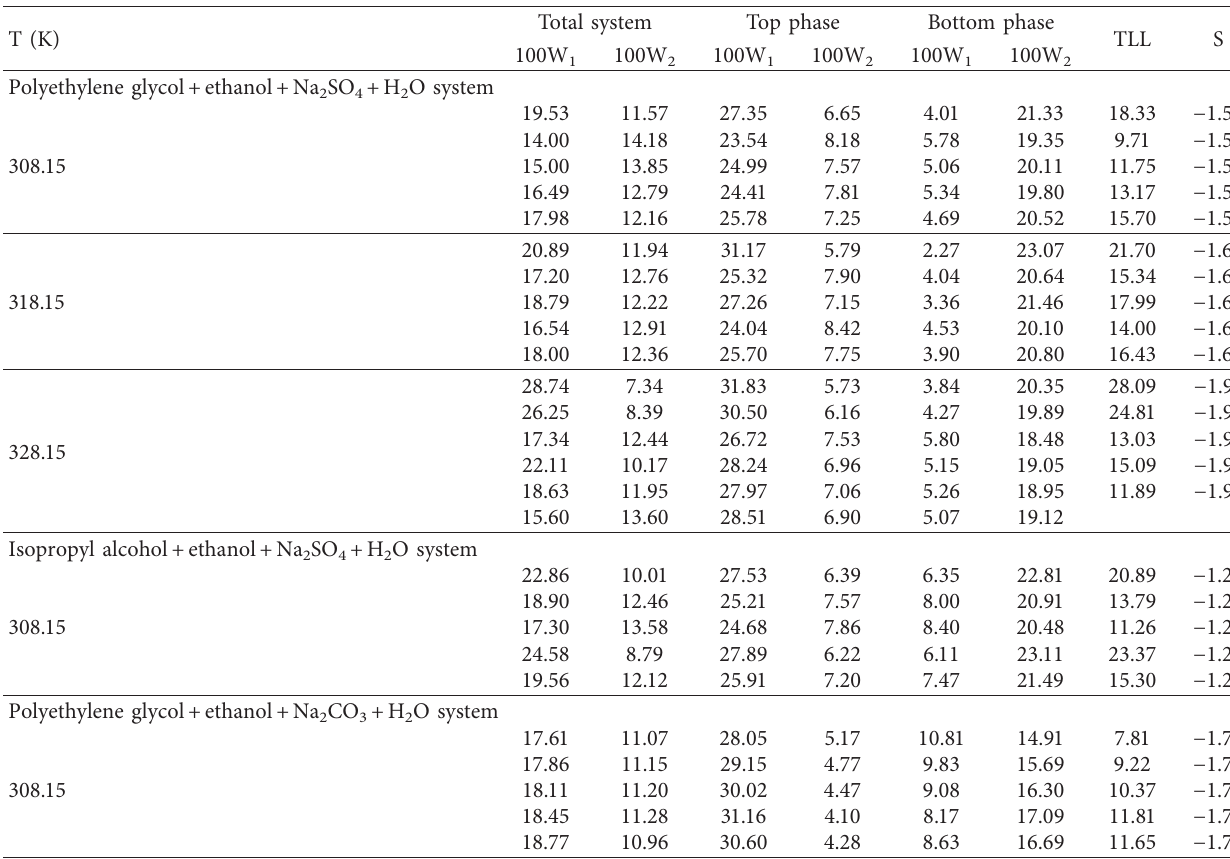
2 CO 3 /Na 2 SO 4 )+water ATPSs at different